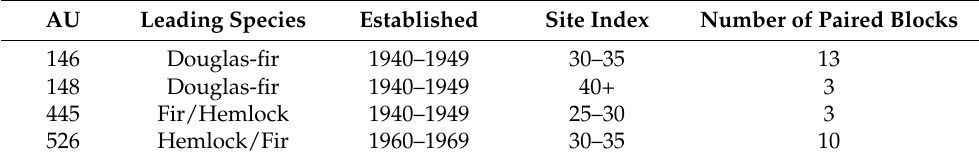
Figure 2. LiDAR paired block design in the DF49a area showing the fertilization boundary, buffered offsets, and sample plots’ location within cells (dashed circles). Table 1. Composition and number of final selected LiDAR-block pairs for each analysis